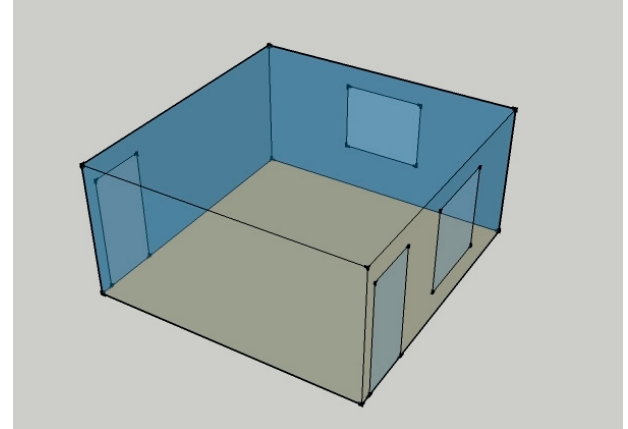
Figure 6. Living room in singly zoned model.